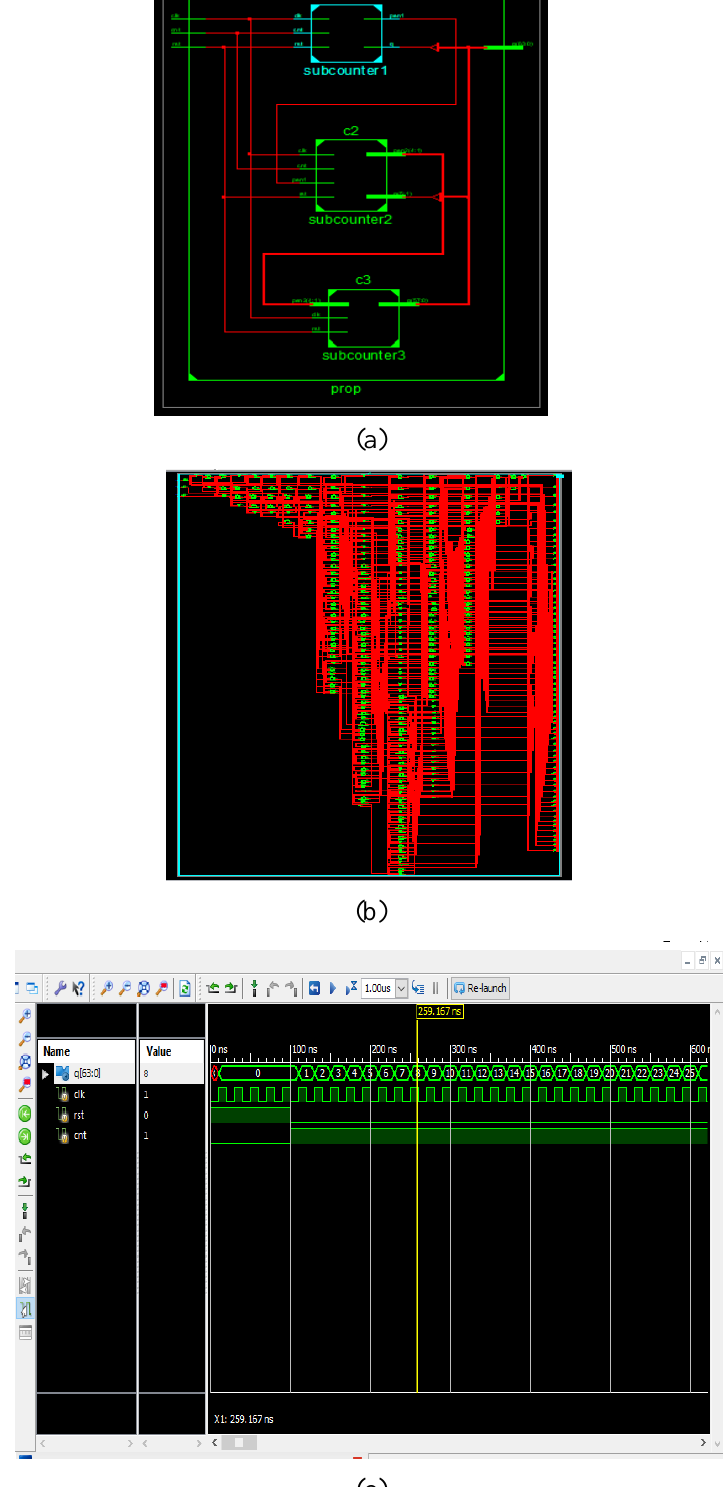
Figure 6 . (a) RTL Schematic; (b) Technology Schematic; (c)